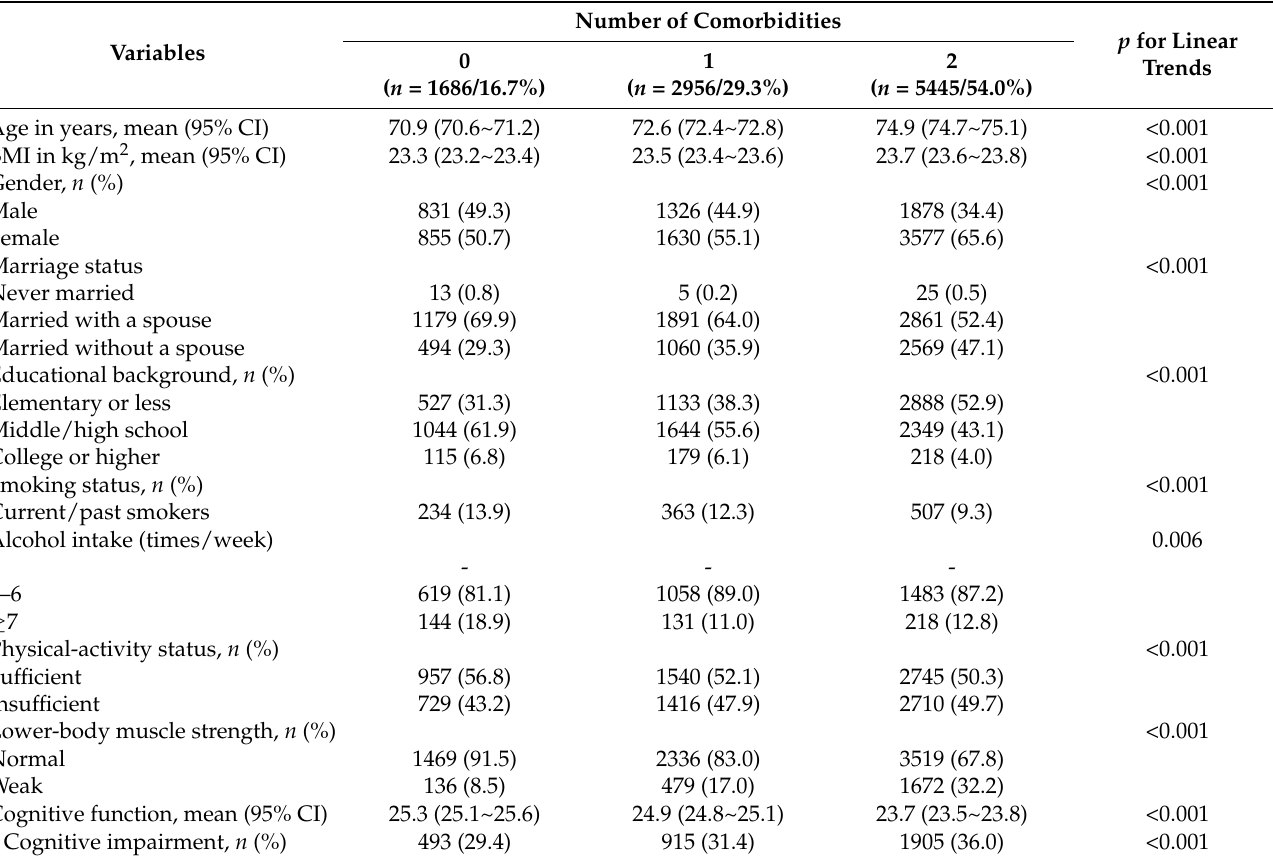
Table 1. Descriptive statistics of study participants by